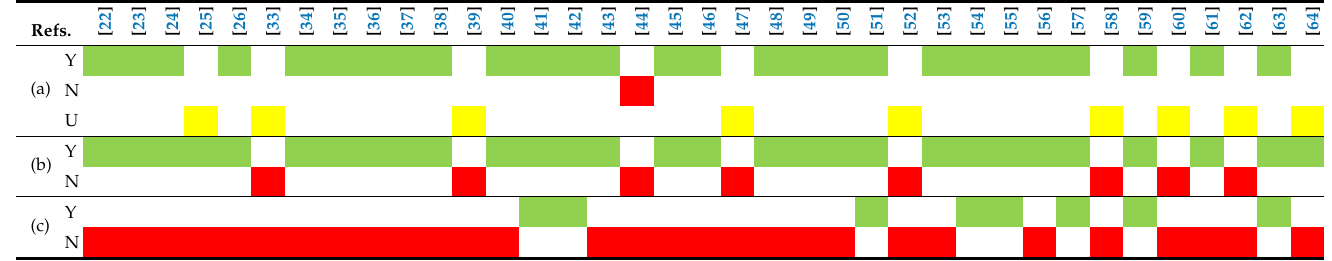
Table 2. Relationship between selected studies and the review objective.